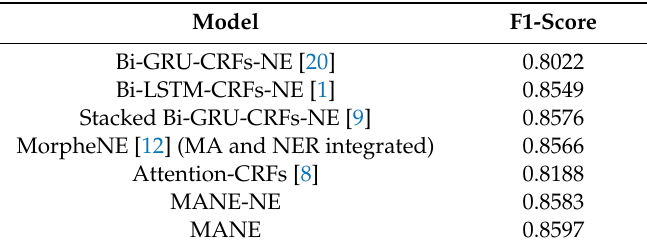
Table 6. Performance comparison on named entity